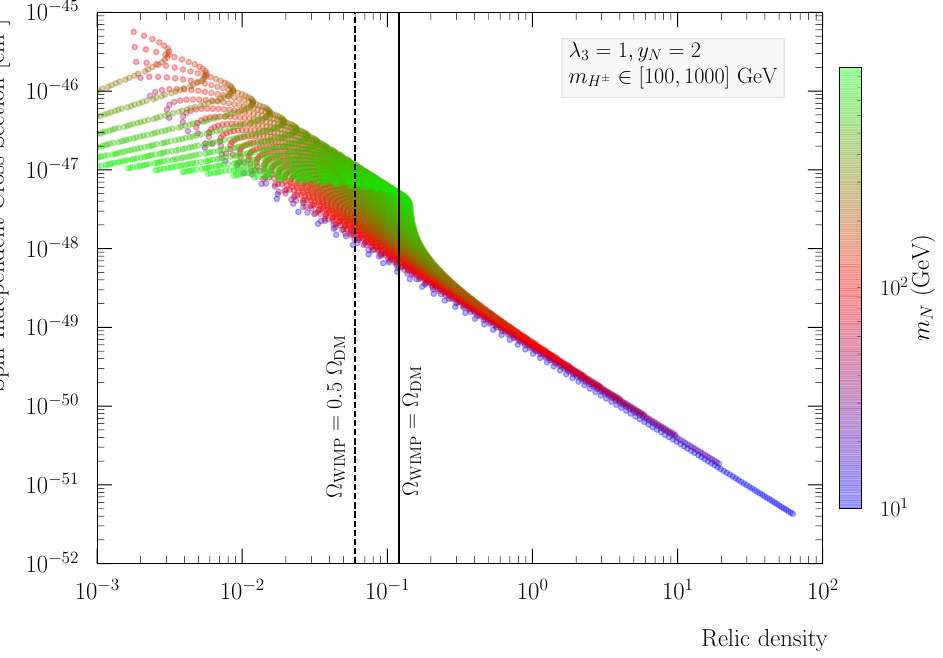
Figure 4 . Correlation between the relic density and the spin-independent direct detection cross section. The palette shows the value of the DM mass. The two vertical lines correspond to Ω Ω 2 (solid) and Ω 2 = 0 . 5 Ω 2 Planck h N h Planck h